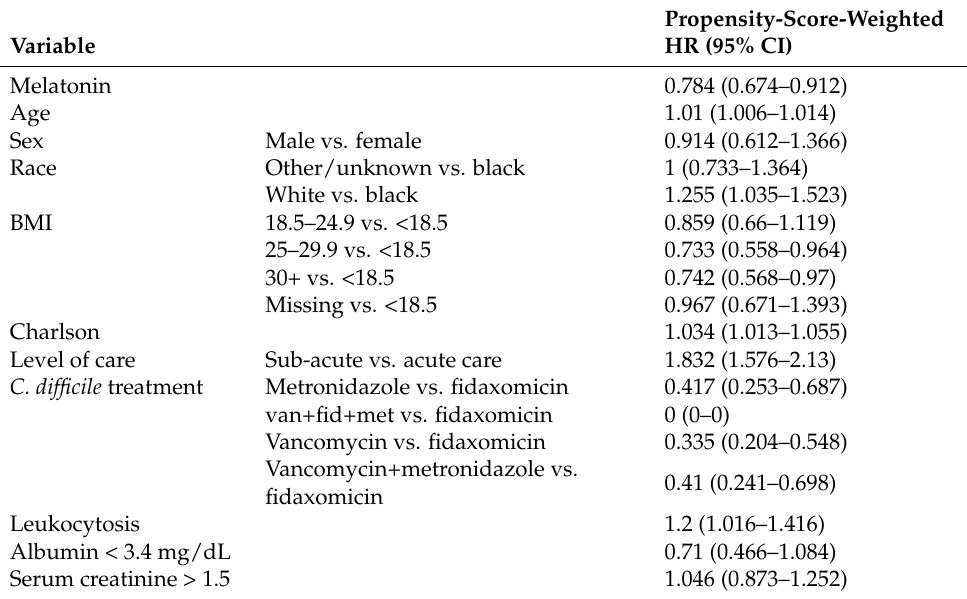
Figure 2. Kaplan–Meier curve of the two cohorts, weighted results. A p value < 0.001 demonstrates a statistically significant difference in recurrent CDI among the weighted cohorts for the melatonin- exposed compared to the unexposed cohort. Table 4. Propensity-score-weighted model evaluating the risk of recurrent Clostridioides difficile